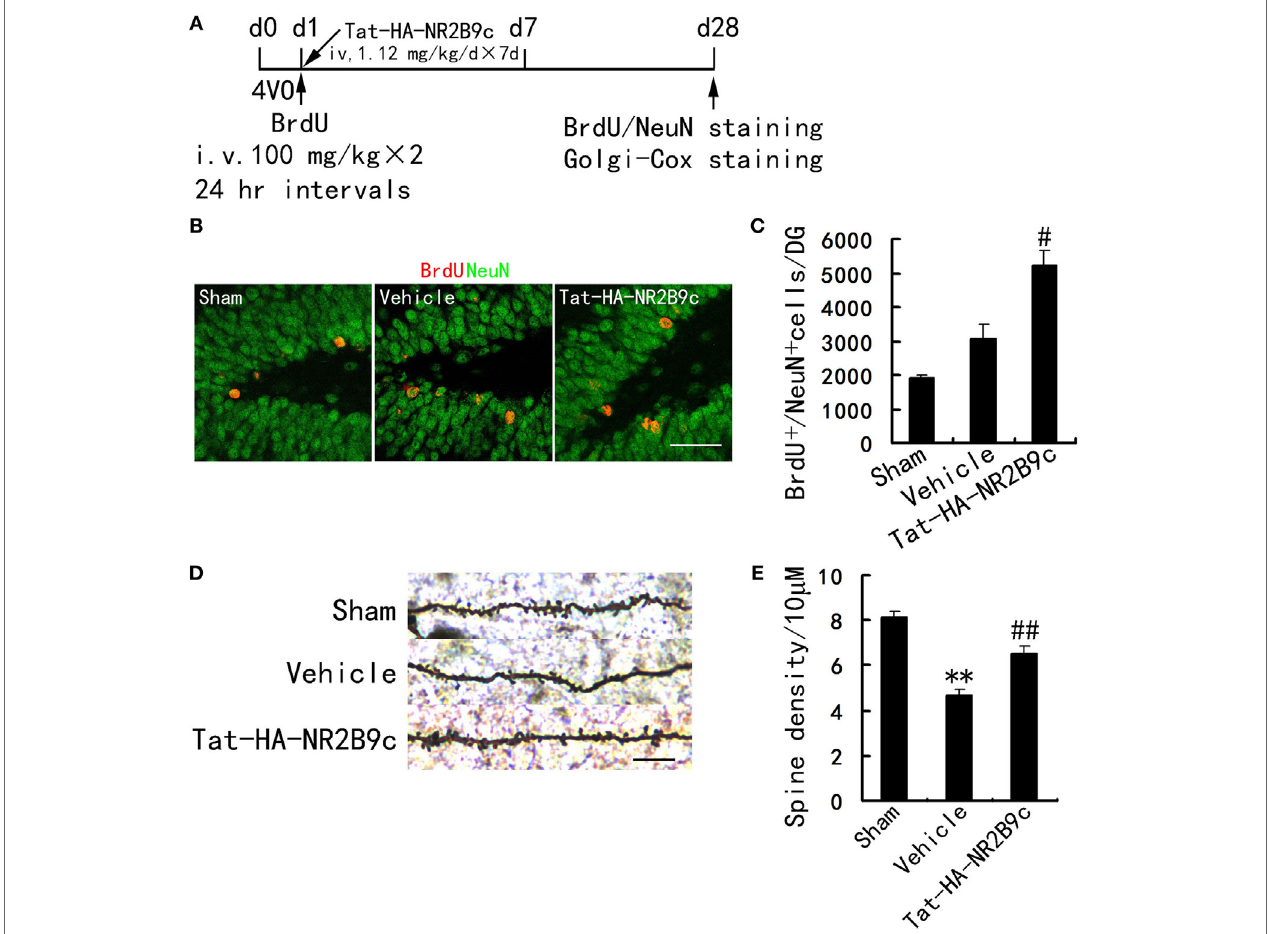
FigUre 2 | Tat-HA-NR2B9c increases neurogenesis in DG and ameliorates dendrite spine loss of pyramidal neurons in hippocampus CA1 region after transient global ischemia (TGI). (a) Schematic representation of experimental design for (B–e) . (B,c) Images and bar graph showing BrdU + /NeuN + cells in dentate gyrus at day 28 after TGI ( n = 7 for all groups). Scale bar, 50 µm. (D,e) Images and bar graph showing dendrite spine density in hippocampus CA1 region in rats subjected to TGI and treated with Tat-HA-NR2B9c ( n = 5 for all groups; eight neurons were measured in each biological sample). Scale bar, 10 µm. Data are mean ± SEM (** P < 0.01 vs sham; # P < 0.05, ## P < 0.01 vs